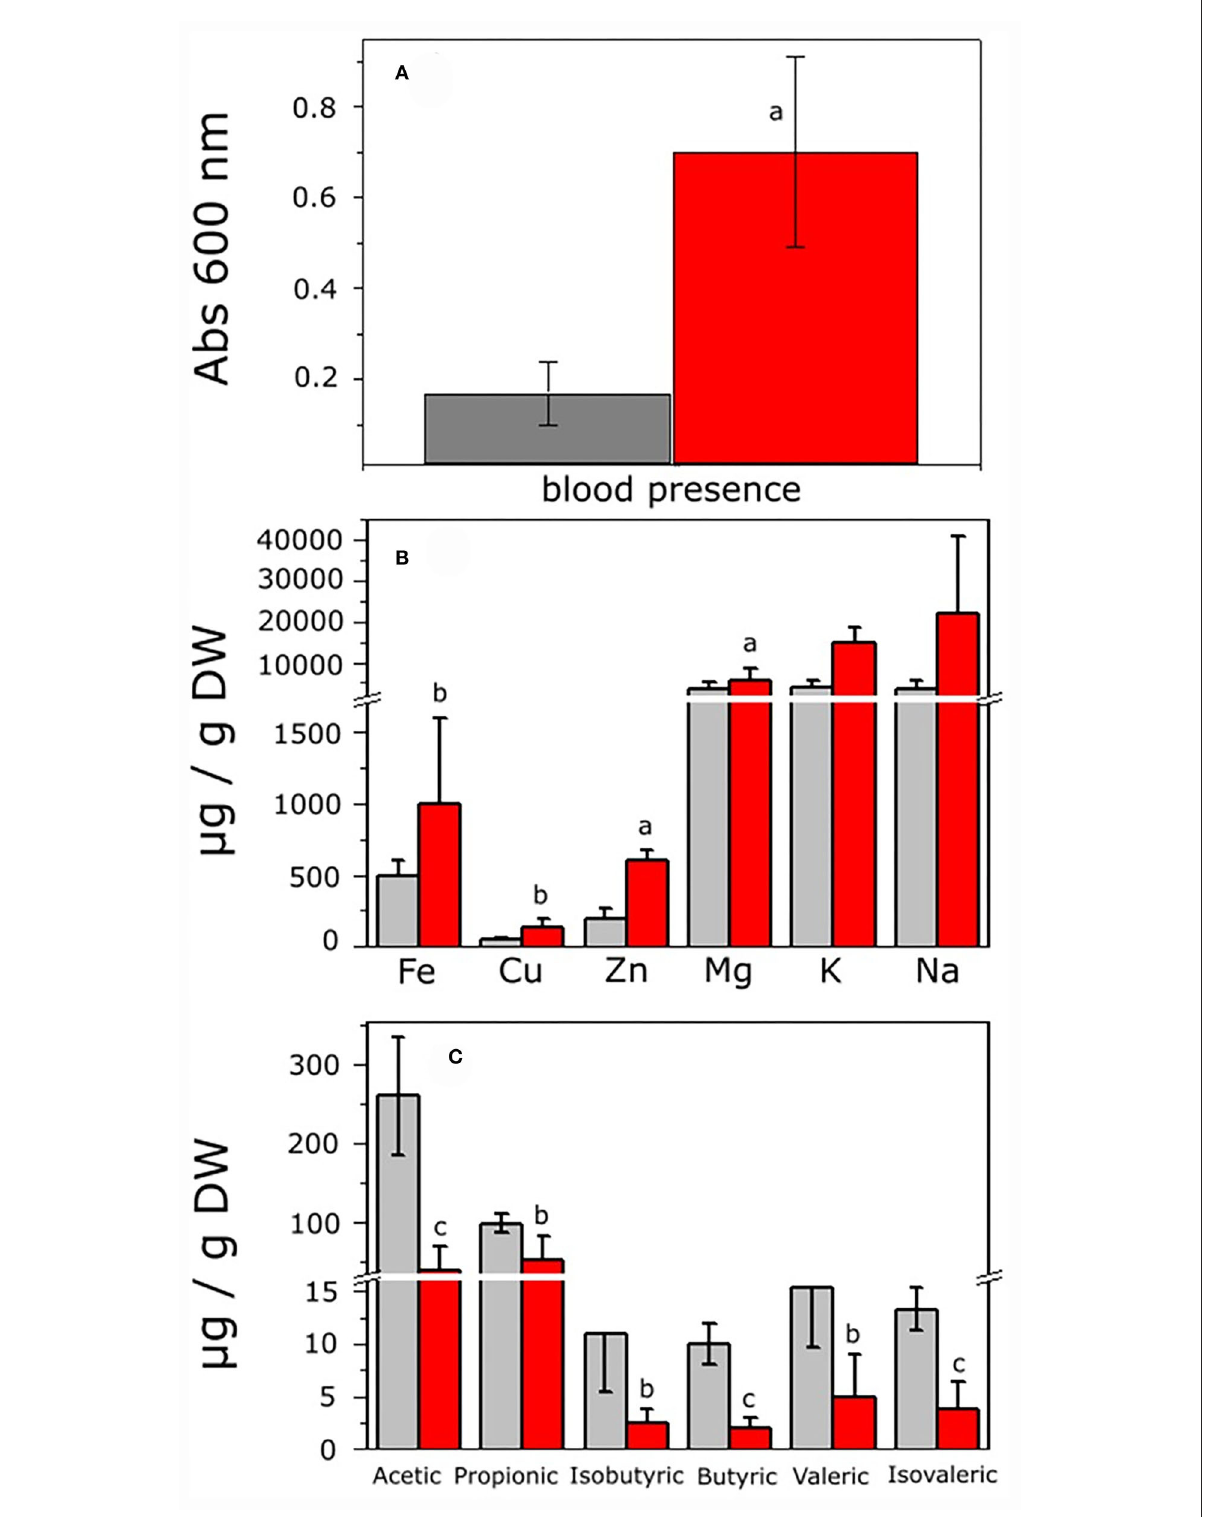
FIGURE2 Analysis of feces from control and hepatoma-bearing rats. Feces were collected from control and rats with hepatoma and processed as indicated in the Methods section. (A) Detection of blood in feces as determined by the toluidine blue method. (B) Fe, Cu, Zn, Mg, K, and Na were determined by ICP-OES analysis. (C) SCOAs were extracted and acetic, propionic, isobutyric, butyric, valeric, and isovaleric acids quantified by gas chromatography, as described in the Supplementary materials. Values shown are the mean ± SD of six (for blood detection), five (for SCOA determination), and 12 (for ionomics) different rats, respectively. a P < 0.01; b P < 0.05; c P < 0.001 vs feces from control